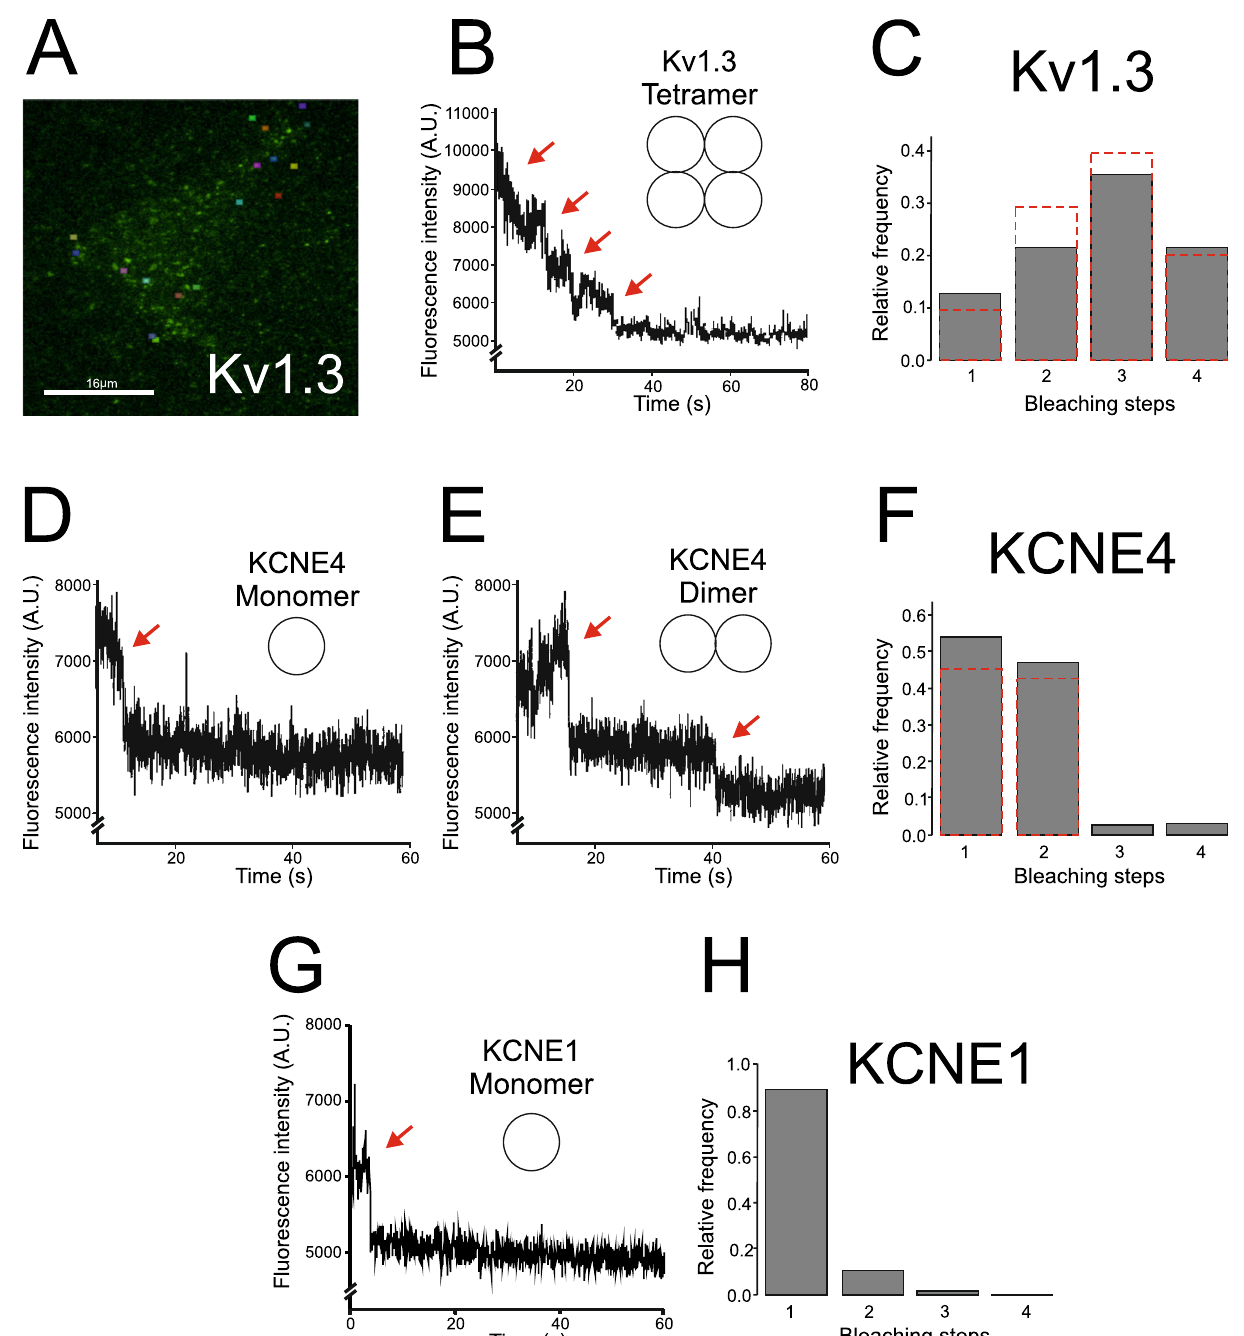
Figure 4. GFP bleaching steps from HEK-293 cells transfected with Kv1.3, KCNE4 and KCNE1. ( A – C ) Cells were transfected with Kv1.3 loopBADGFP. ( A ) Representative snapshot from the TIRFM video (488 nm laser). Colored ROIs (6 × 6 pixels) indicate representative analyzed unmoving spots. Scale bar represents 16 μm. ( B ) Representative graph of bleaching steps from different spots that were analyzed. Red arrows point to 4 bleaching steps. ( C ) Relative frequency of 1–4 bleaching events counted per spot. Gray bars correspond to the experimental frequency observed. Red dashed lines correspond to the theoretical distribution of the bleaching steps with p = 0.67. ( D–F ) GFP bleaching steps with HEK-293 cells transfected with KCNE4 loopBADGFP. ( D , E ) Representative graphs of the bleaching steps from different KCNE4 spots that were analyzed. ( D ) Red arrows point to one bleaching step, indicating a